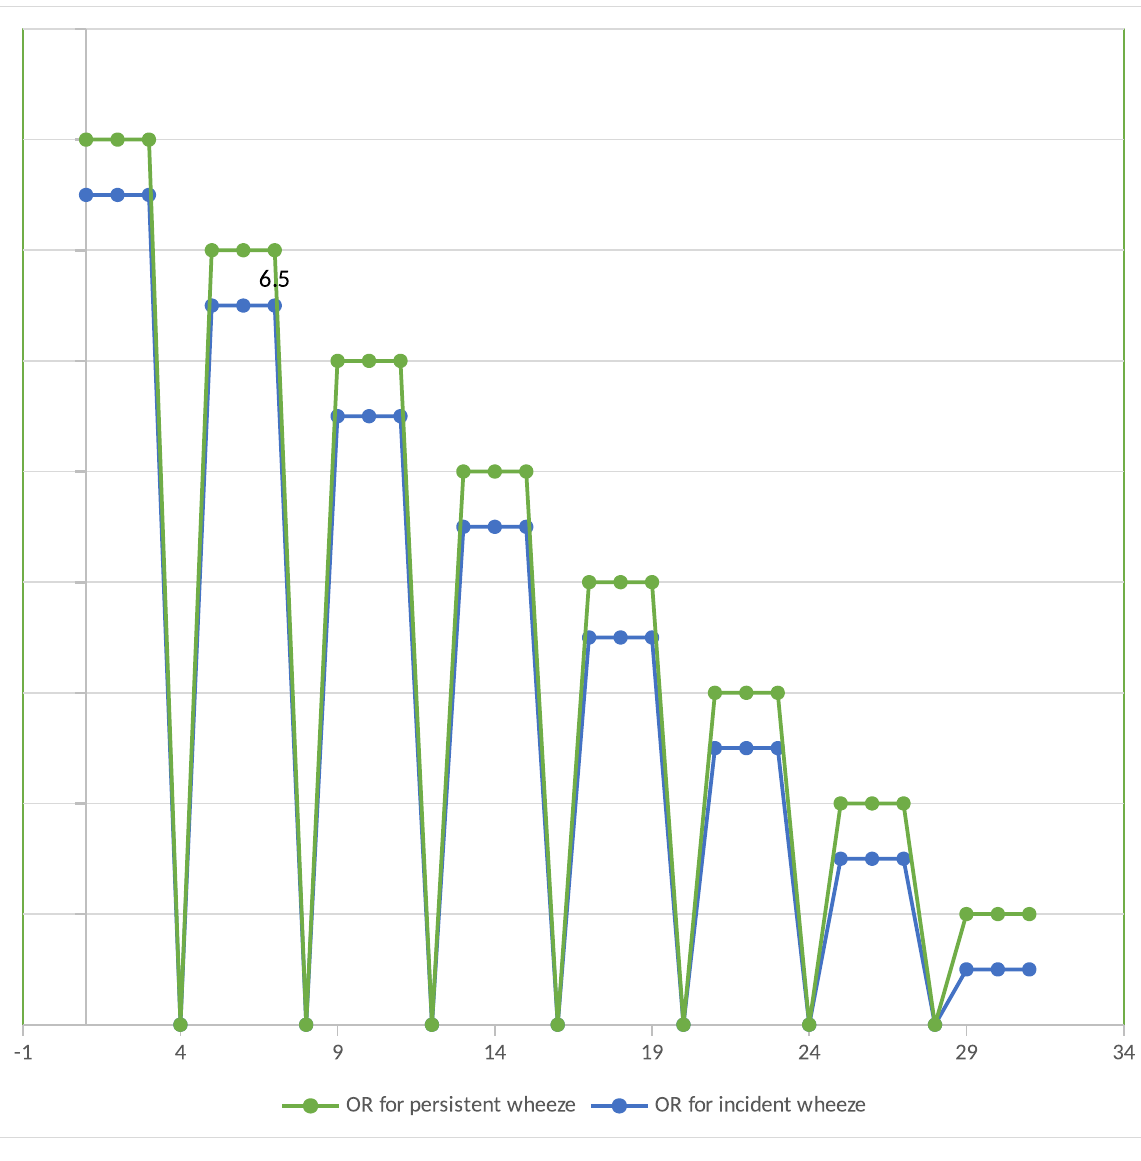
Fig 2. Factors associated with persistent and incident wheezing at one year compared to non-wheezers (odds-ratios from backward logistic